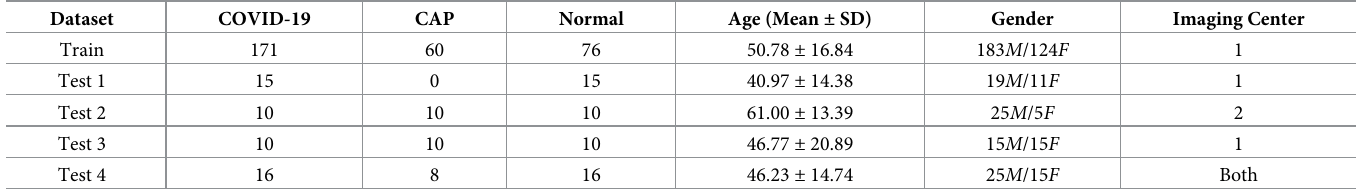
Table 1. Number of cases, demographic data, and additional acquisition information for each dataset.